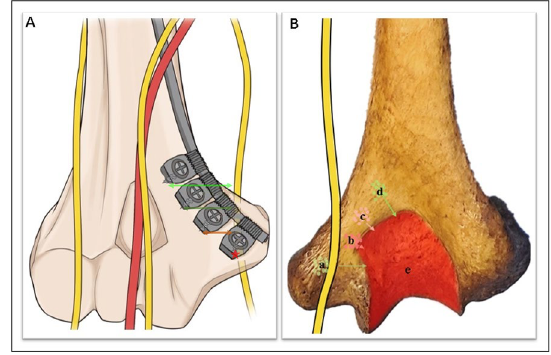
Fig. 6 A The distal end of the plate with four screws crosses the distance between the tip of the bicortical cortex and the ulnar nerve. B The distance between the olecranon fossa and the tip of the four screws (regions a – d ) at the distal end of the plate in the medial humeral epicondyle. The red area ( e ) represents the olecranon fossa and the articular surface of the